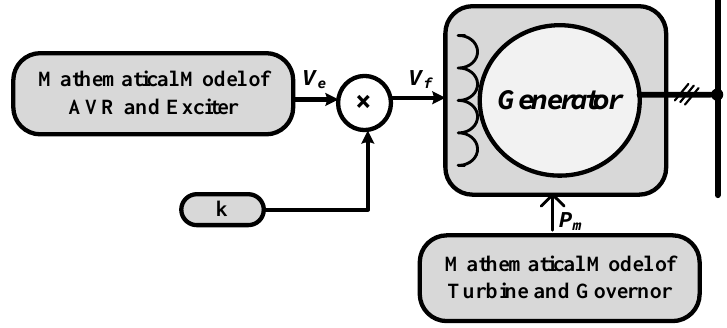
Figure 2. Common structure of the dq model for LOE studies.